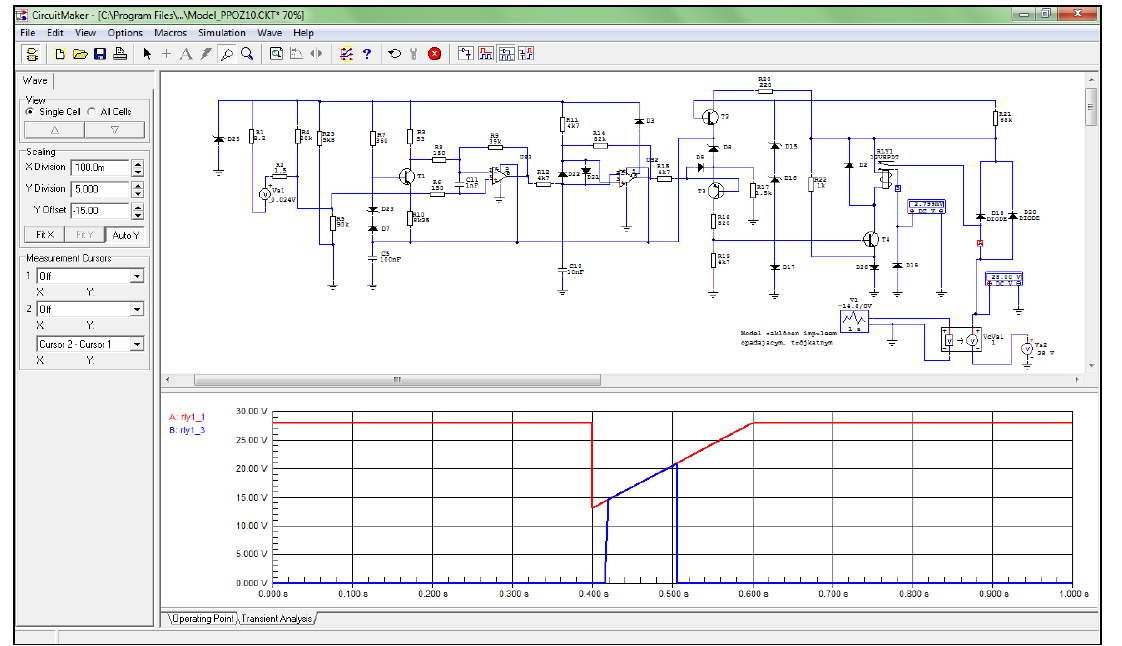
Figure 11. Voltage waveform at the RES − 52 relay output (blue) for 24 mV.